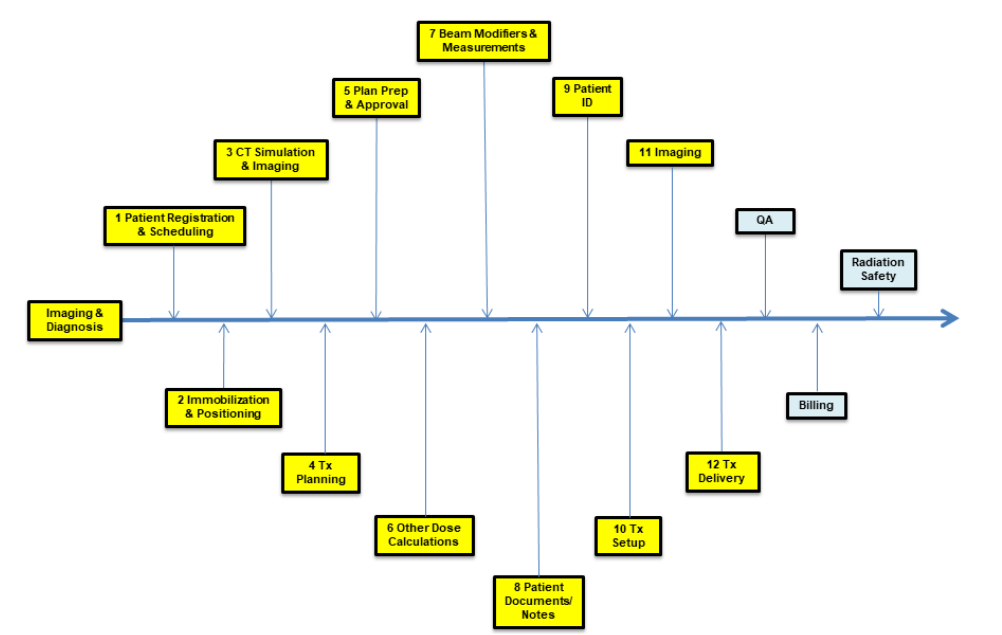
Figure 1. Process map showing the major steps in the radiation oncology